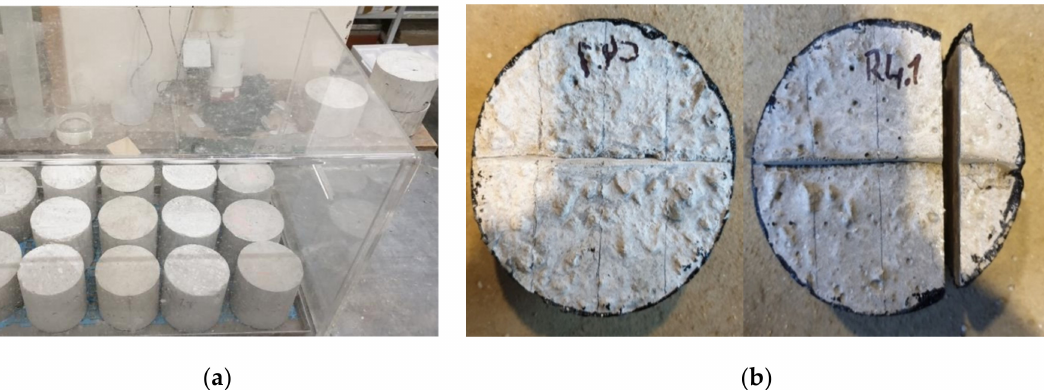
Figure 2. ( a ) Capillary absorption test. ( b ) Measure of carbonation depth in different sections, perpendicular to the